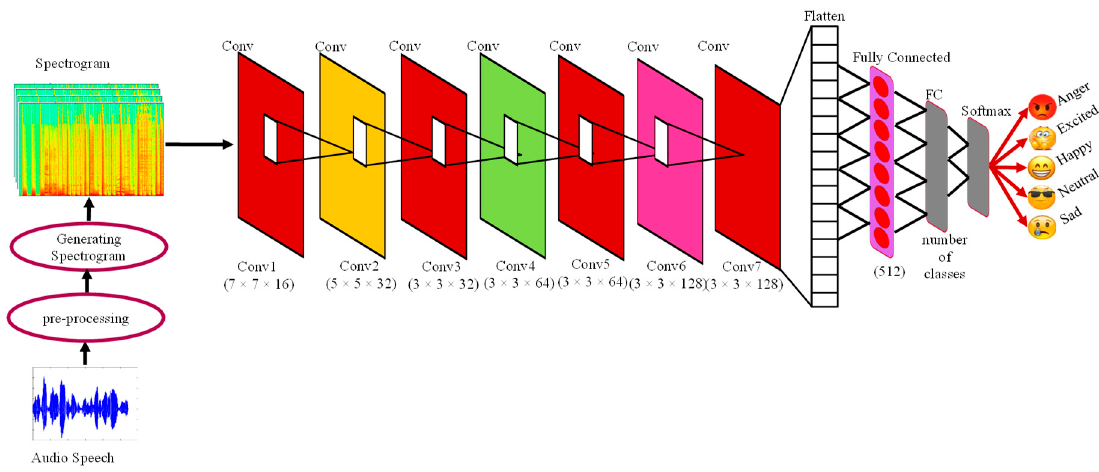
Figure 3. Overall architecture of the proposed deep stride convolutional neural network for speech emotion